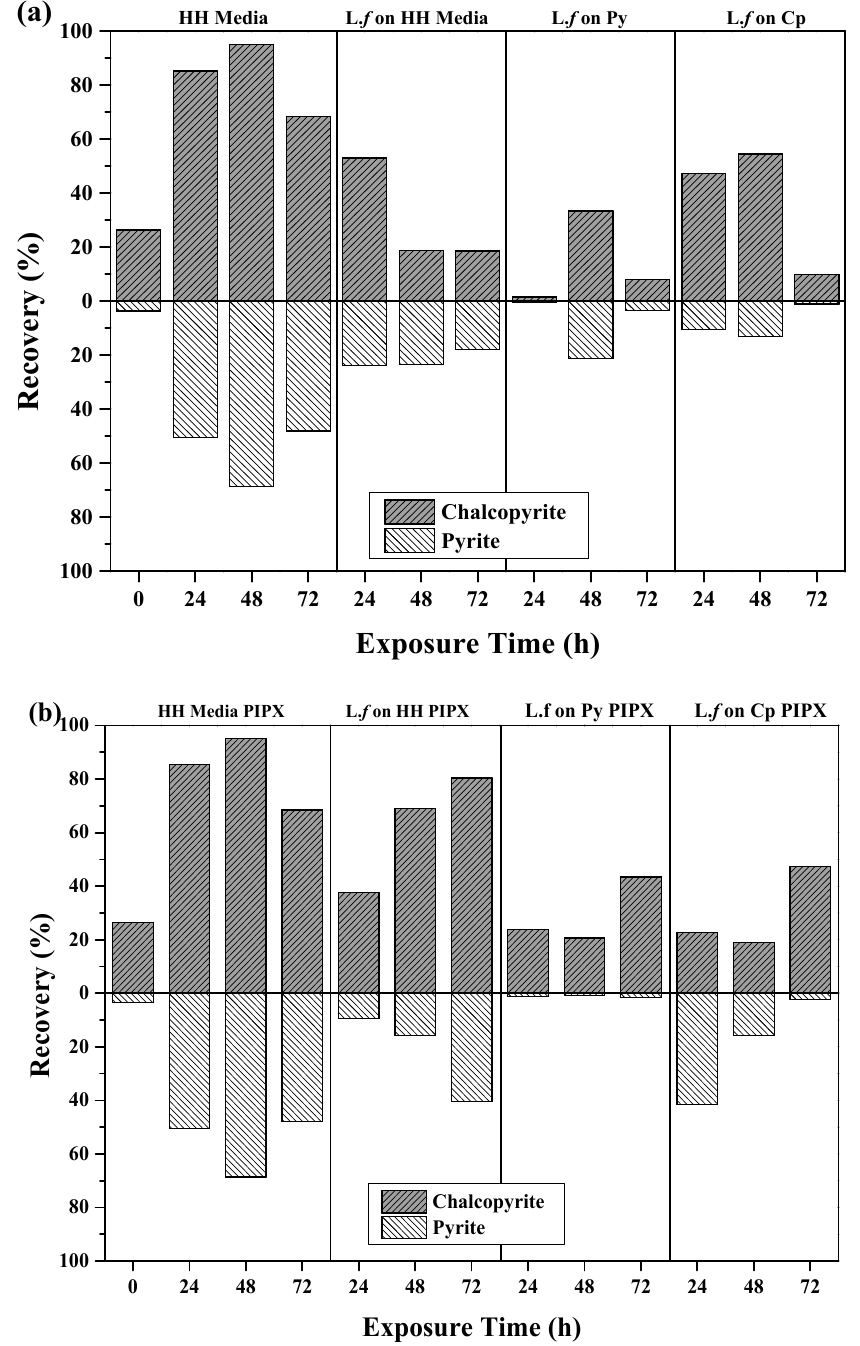
Figure 6. Recovery of Cp and Py as a function of growth conditions. ( a ) Collectorless flotation tests and ( b ) in the presence of PIPX collector.